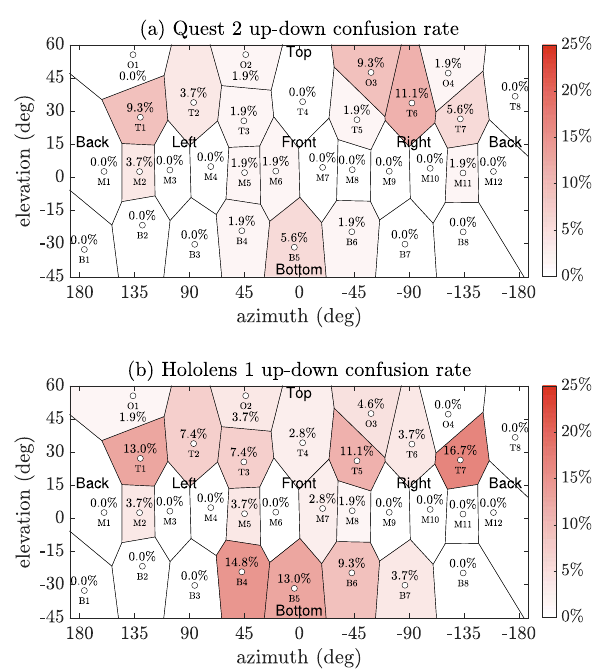
Figure 7. Localization performance (text values) across speaker positions, depicting up – down confusion rates for the (a) Quest 2 and (b) Hololens 1 conditions. Metric values are reported above each speaker position (white circles), around which Voronoi cells have been drawn to simplify results